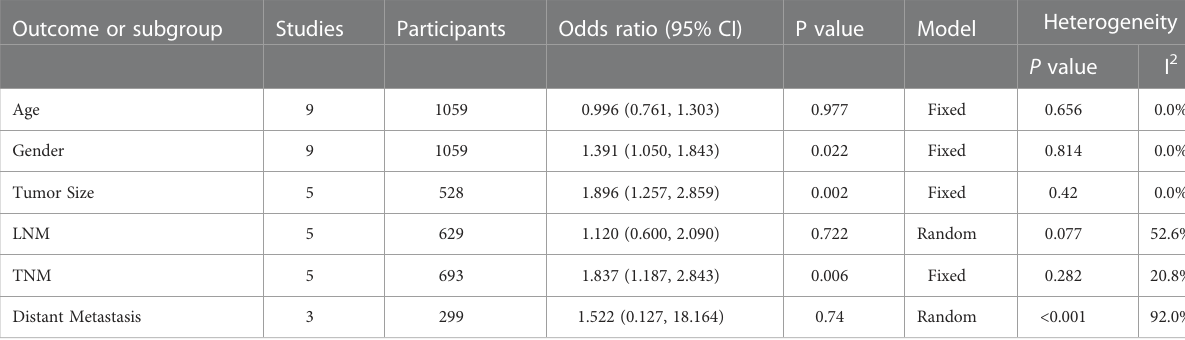
TABLE 4 Association between Siglec-15 and other clinicopathologic parameters. Outcome or